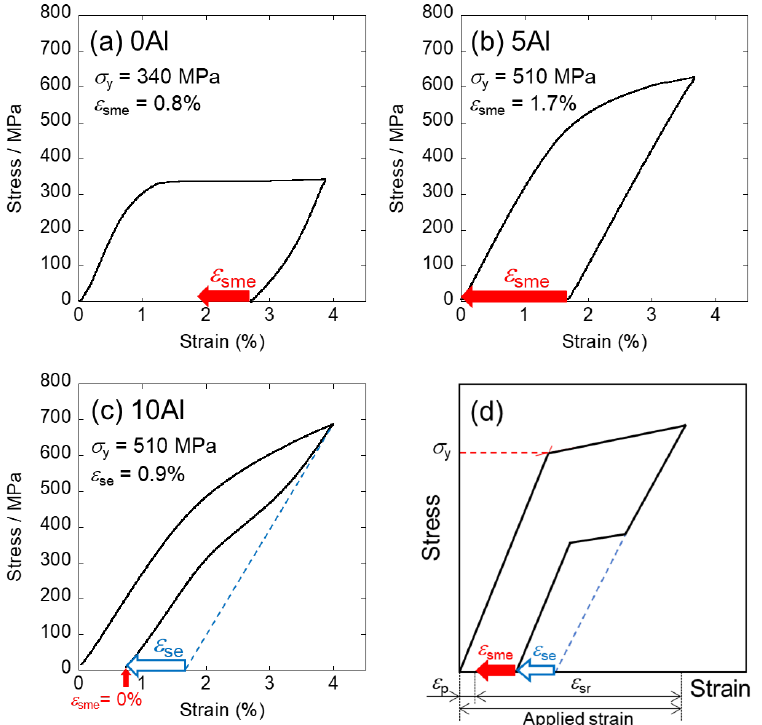
Figure 3. Stress-strain curves of ( a ) 0Al, ( b ) 5Al, and ( c ) 10Al. ( d ) Definition of each term. (Open blue arrow symbols: strain originates from superelasticity during unloading ( ε se ); solid red arrow symbols: strain brought by SME upon heating ( ε sme ); ε sr : strain of overall shape recovery; ε p : strain by plastic deformation; σ y : yielding stress; applied strain = ε sr + ε p ).